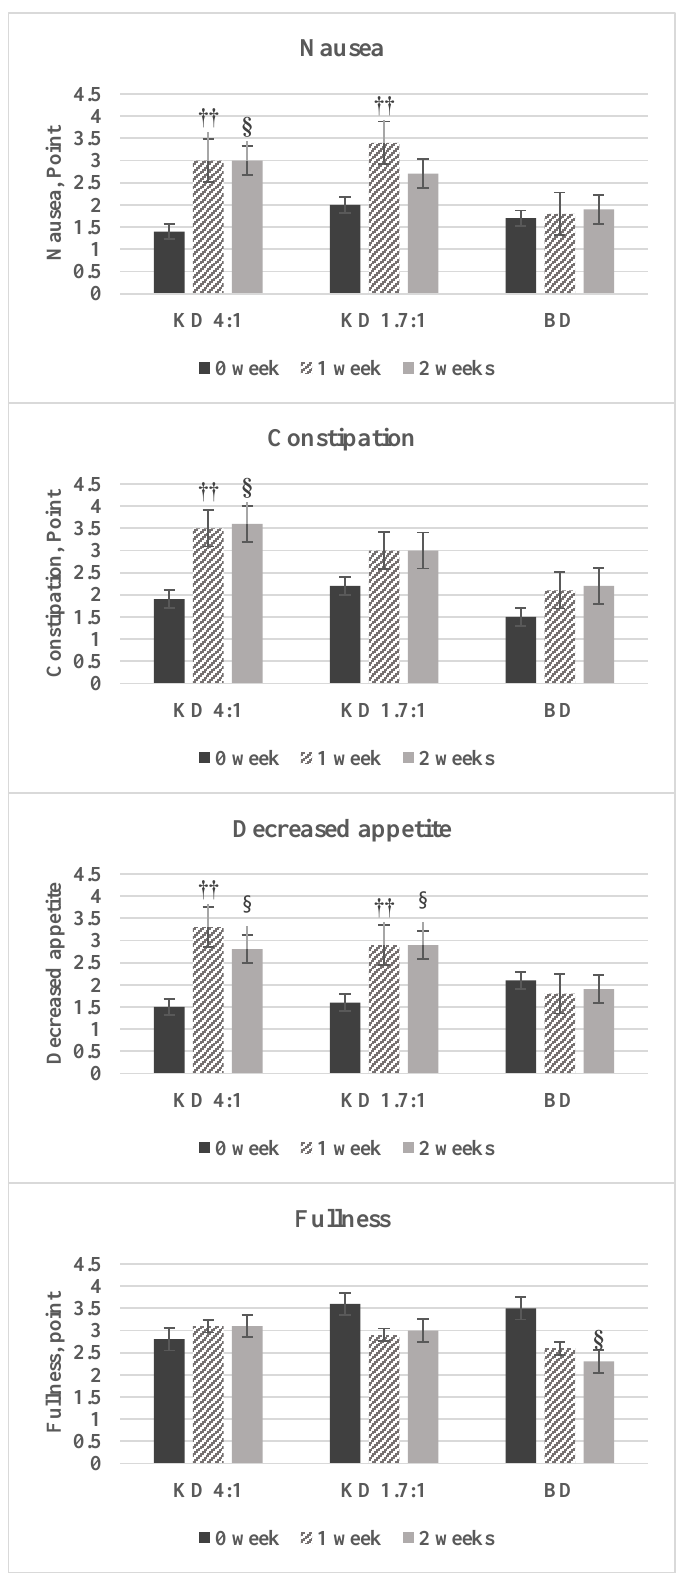
Figure 3. Changes in symptom scores (side effects) reported by each group. †† Significant difference between 0 week and 1 week by Paired t -test, Wilcoxon signed rank test; § Significant difference between 0 week and 2 weeks by Paired t -test, Wilcoxon signed rank test.